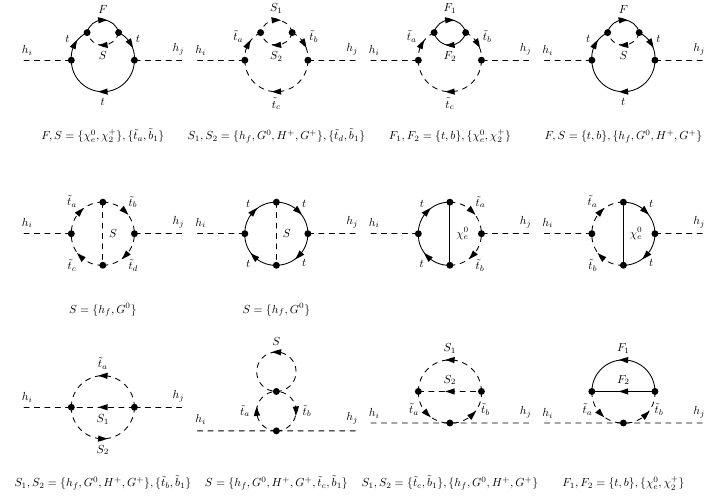
Figure 14 . Generic two-loop self-energies of the neutral Higgs bosons contributing to the two-loop corrections of the neutral Higgs boson masses at O ( (cid:11) 2 ). The placeholders S i and F i ( i = 1 ; 2) stand t for the particle content of the diagrams speci(cid:12)ed below the respective diagrams. Diagrams with a cross denote the insertion of the respective one-loop counterterms of the vertices and masses. A summation over all internal particles with indices a; b; c; d = 1 ; 2, e = 3 ; 4 ; 5 and f = 1 ; : : : ; 5 is implicit. Note that additional diagrams that di(cid:11)er from the ones shown only by the inversion of the fermion current are not explicitly shown.